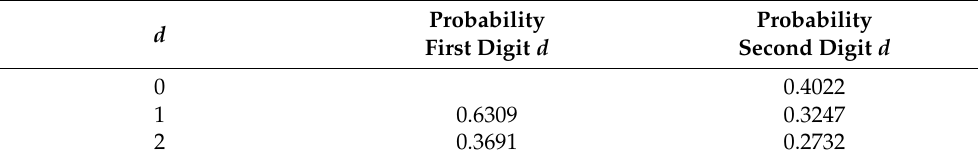
Figure 2. The distribution of the leading digit base 10 according to Benford’s law. Table 2 provides analogous probabilities for the distribution of the first and second digits of 1-BL 3 and second digit base 3 (2-BL 3) probabilities, and Figure 3 provides a visual representation of the distribution of the leading digits under base 3 representations. Table 2. Benford probabilities for first digit base 3 (to four decimal places).